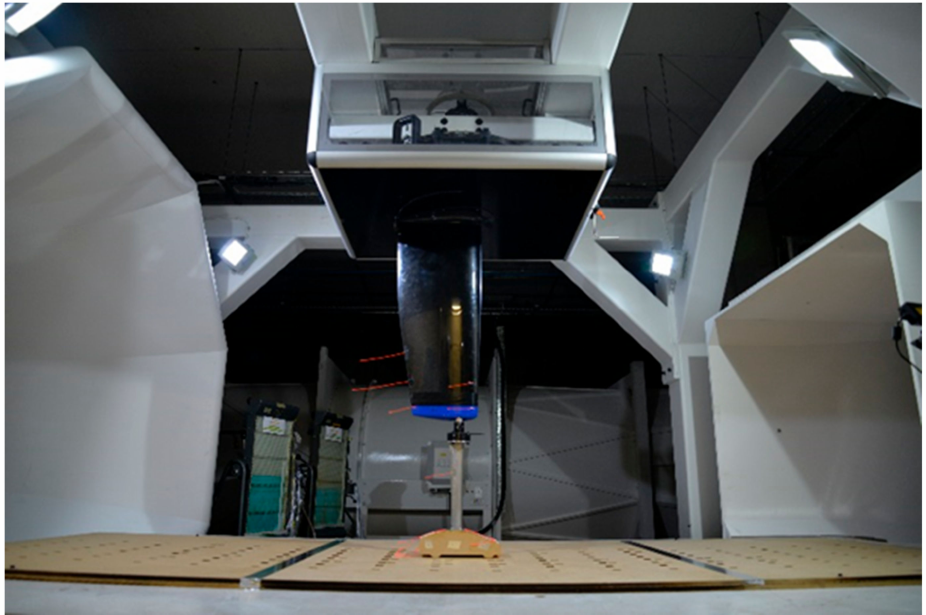
Figure 4. “Measurement Model” shown positioned in the wind tunnel with overhead balance and streamlined struts arrangements, after [50] © SAE International